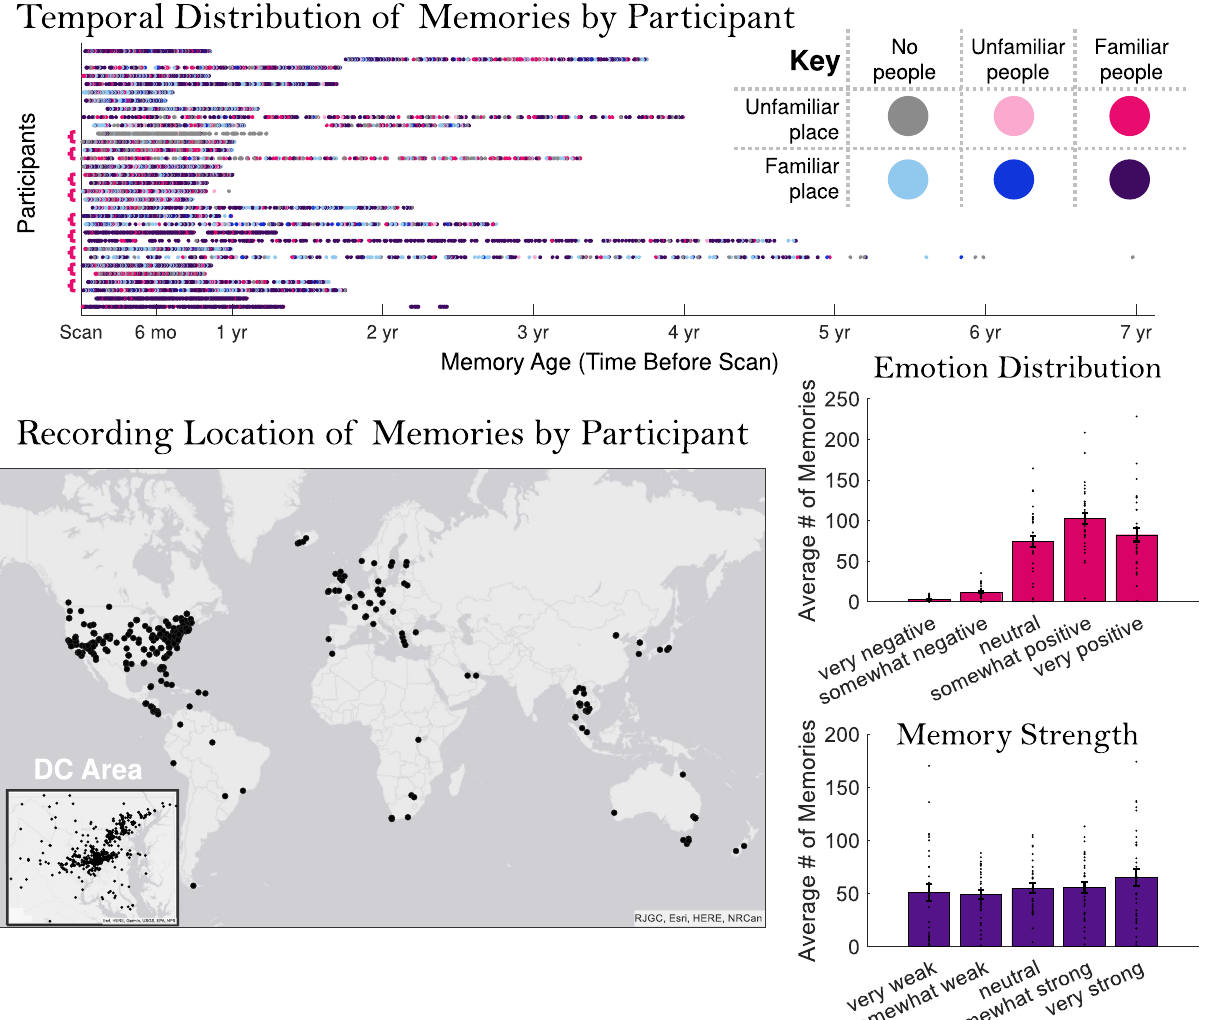
Fig.2|Thediversityofmemoriesinthestudy. Theseplotsshowthedistributions of the ~300 memories per participant used in the current study along a range of metrics. The temporal distribution shows a scatterplot of the age of each of the participants ’ memories. Each horizontal row represents each of the 32 experi- mental samples, and samples from the same participant ( N =9) are indicated with brackets at the left. While many memories occurred within one year of the experimental scan, several participants had memories extending more than a year prior, and some up to seven years prior to the experiment. Dots are color-coded based on memory content (whether there are familiar/unfamiliar people in the video, and whether it occurs in a familiar place). The content types are diverse across participants, with some recording a majority of videos with familiar people